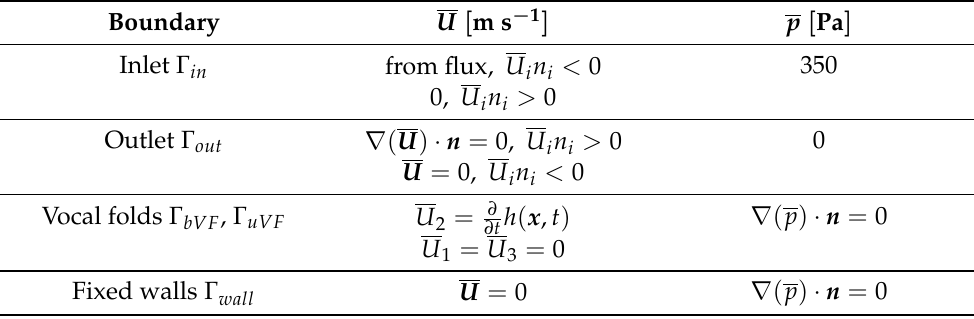
Figure 1. CFD computational domain in mid–coronal section and details of the CFD mesh near the vocal and ventricular folds. The z-normal boundaries are denoted Γ front and Γ back . Table 1. Boundary conditions for the filtered flow velocity U and static pressure p . The symbol n i is the unit outer normal and h ( x , t ) is the prescribed displacement of the vocal